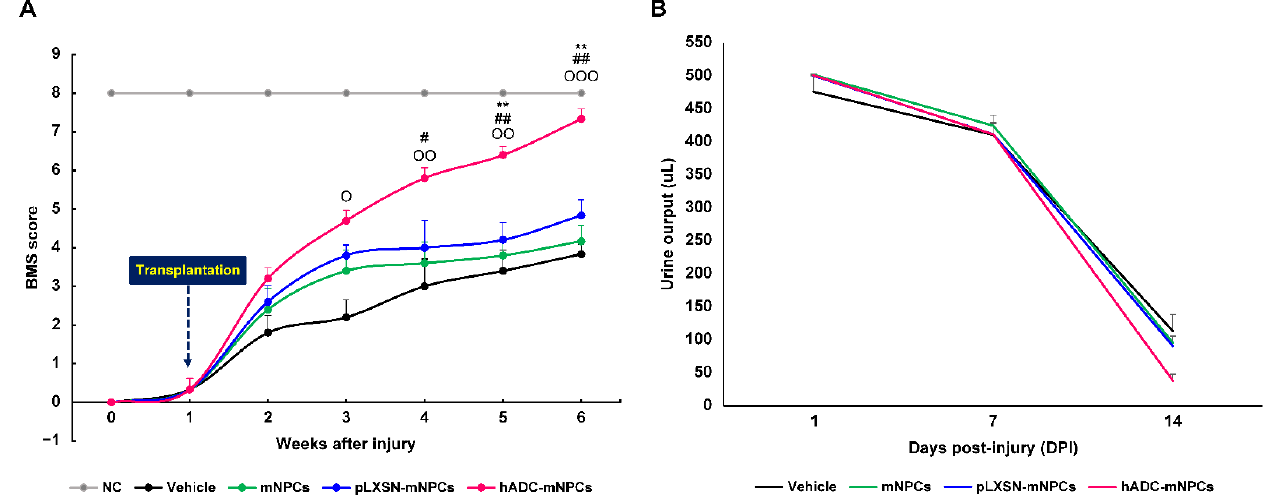
Figure 7. Mice with hADC-overexpressing mNPCs (hADC-mNPCs) exhibit improved motor performances and bladder function recovery. ( A ) Basso Mouse Scale (BMS) score up to 6 weeks after SCI, demonstrating continuous improvement in the hADC-mNPC group compared with other groups at 4, 5, and 6 weeks. ( B ) Comparison of bladder residual urine volumes up to 14 days post-SCI, showing that levels were lower in hADC-mNPC mice than in other mice. Data are presented as means ± SEM. ( n = 10−40 per group, O p < 0.05, OO p < 0.01, OOO p < 0.001 (hADC-mNPCs versus vehicle), # p < 0.05, ## p < 0.01 (hADC-mNPCs versus mNPCs), ** p < 0.01 (hADC-mNPCs versus pLXSN-mNPCs).